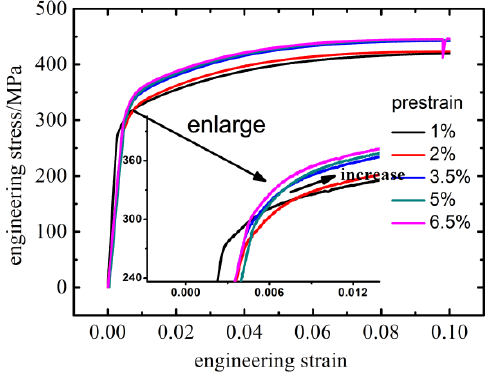
Figure 9. Engineering stress–strain cures of prestrained specimens after annealing (500 °C, 40 min).